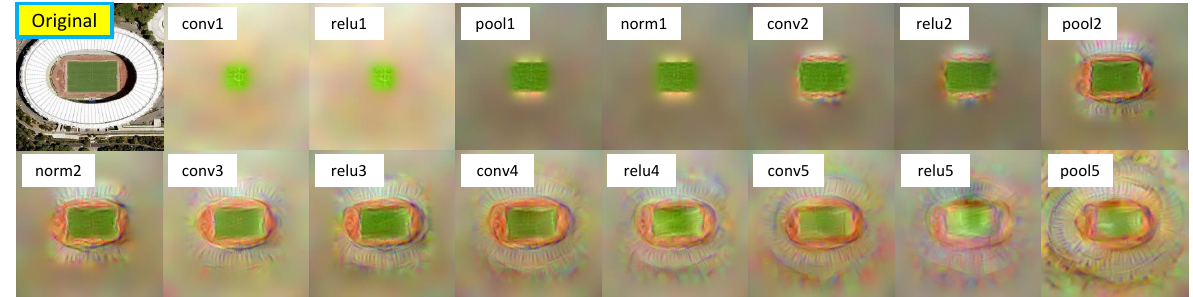
Figure 8. Reconstructed images from a local 5 × 5 region of feature maps at different layers.